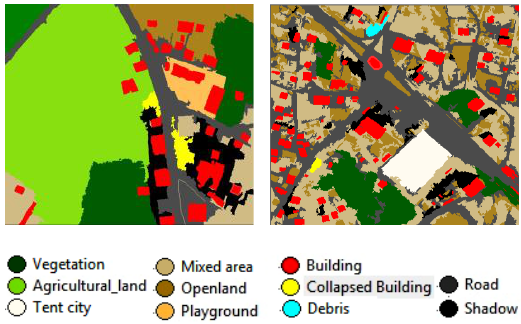
Figure 4: Classification results; Case area 1 (left) and Case area 2 (right).